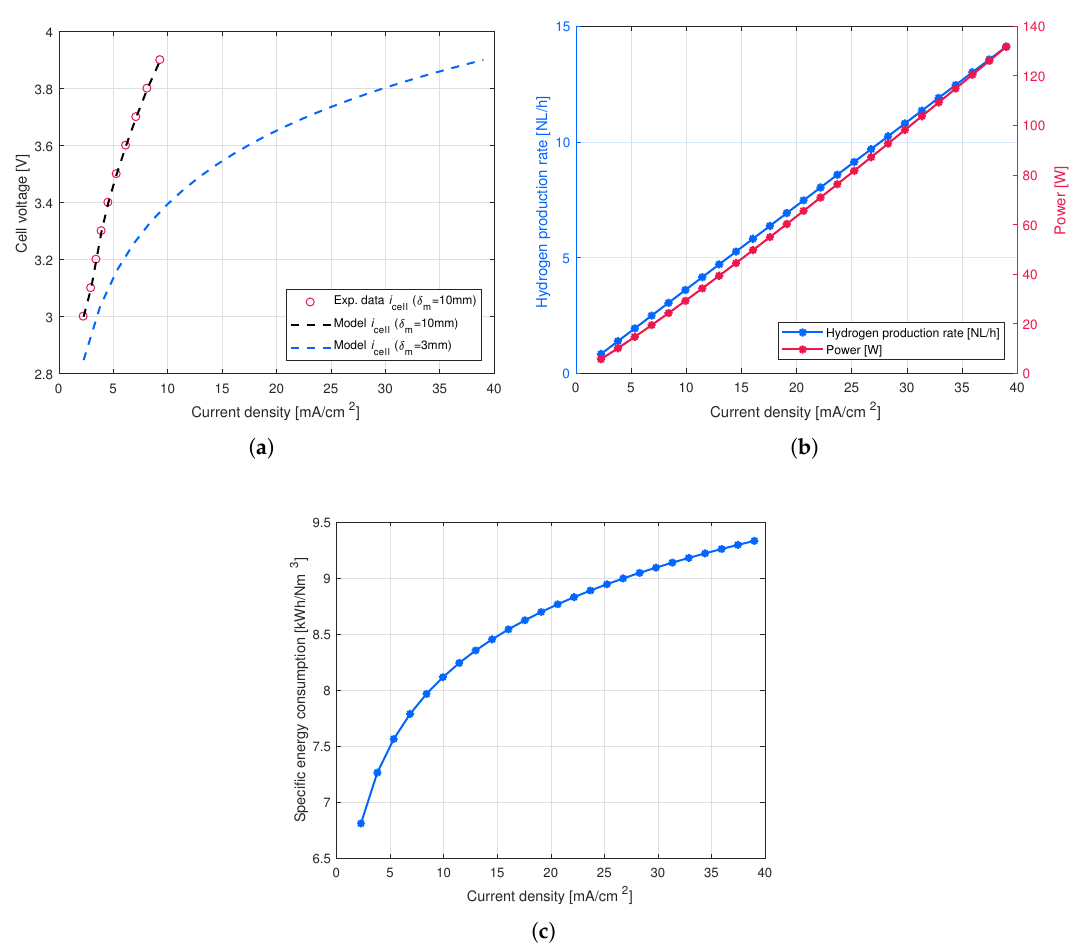
Figure 6. The main energy efficiency parameters of the electrolyzer stack with a decreased distance between the electrodes. ( a ) Cell voltage as a function of current density at variable electrode separations; ( b ) hydrogen production rate and supply power as a function of current density with a 3mm distance between the electrodes; ( c ) specific energy consumption as a function of the current density with a 3mm distance between the